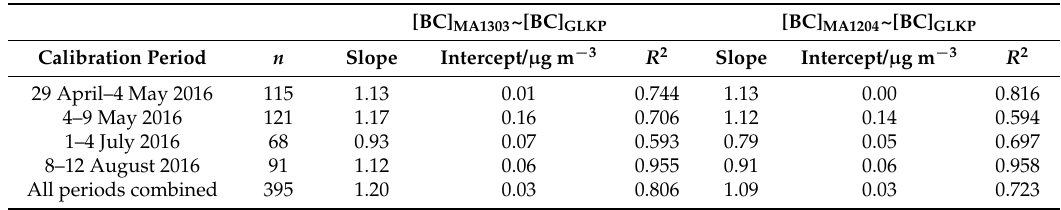
Table 4. Regression statistics of microAeth monitor concentrations ([BC] 1303 and [BC] 1204 ) against the reference analyser at the Glasgow Townhead AURN monitoring station ([BC] GLKP ) (hourly averages) for individual co-location periods and for all periods combined. Associated scatter plots shown in Figure 2c and SI Figure